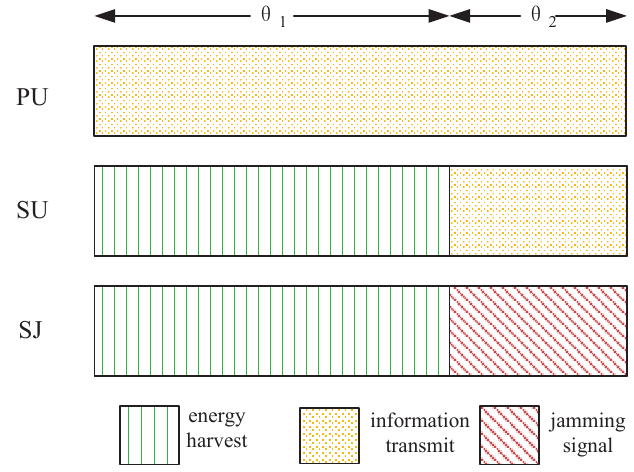
Figure 2. Block structure diagram. θ 1 denotes the ET phase, during which SU and SJ harvest energy from the PU transmissions. θ 2 denotes the IT phase, during which SU transmits confidential information to SR, and SJ generates jamming signals to the